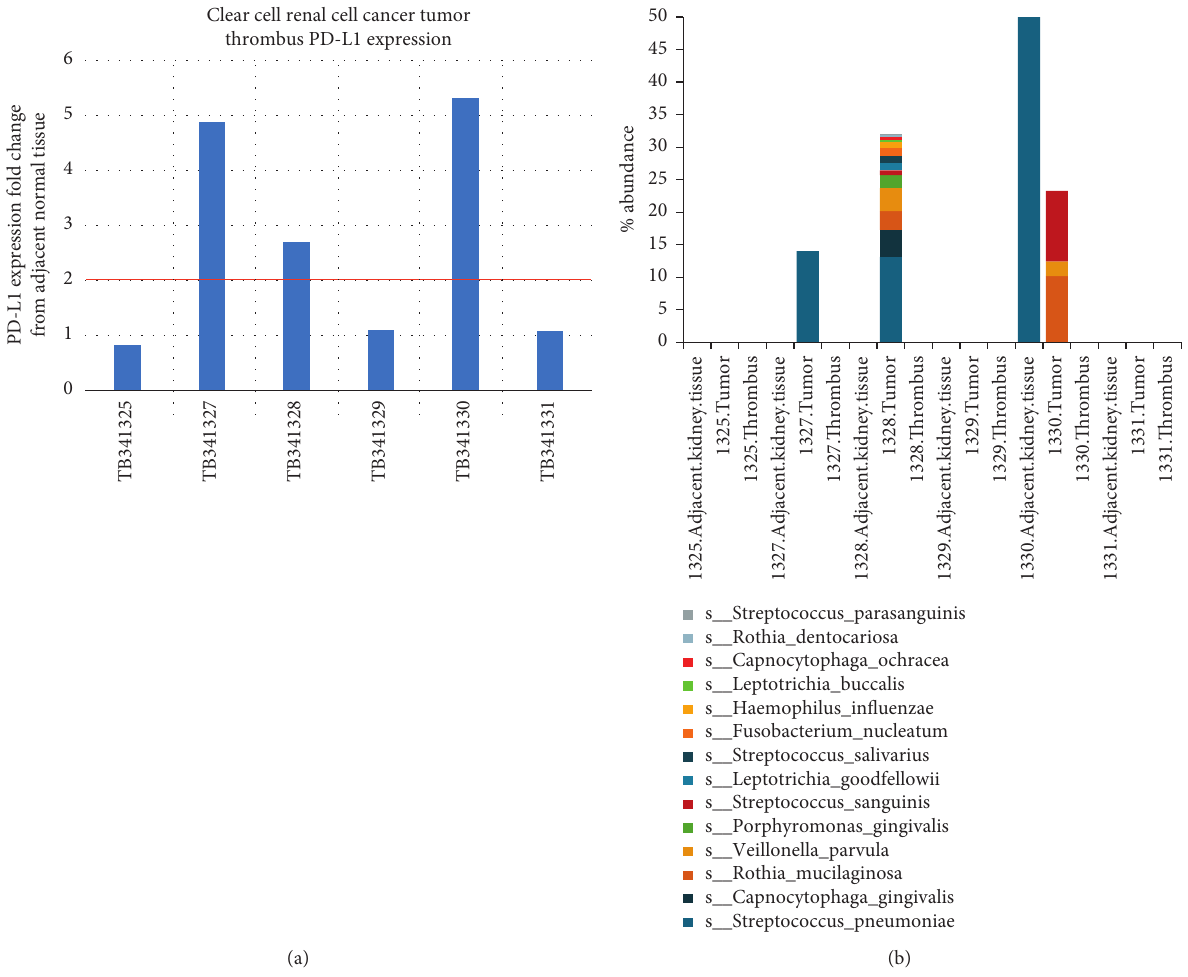
Figure 3: Thrombus PD-L1 expression profile in relation to the presence of oral microbiome within the primary tumor. The top bar graph represents the PD-L1 expression within a renal tumor thrombus compared to background normal adjacent tissue. A two-fold difference is demarcated by the red line. The lower bar graph represents the same tumor specimen’s oral microbiome